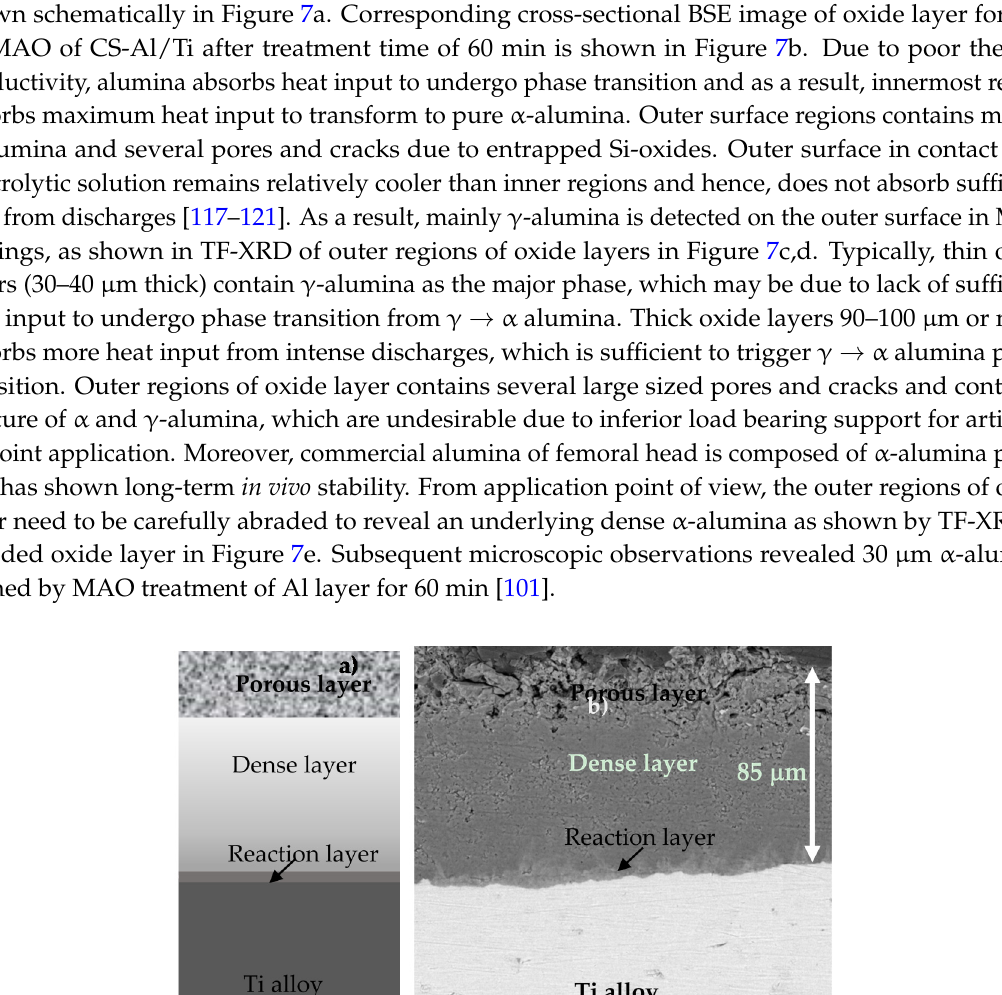
Figure 8. SEM image of cross ‐ section of alumina layer on the Ti alloy formed by MAO of CS ‐ Al layer at pulse frequency of 500 Hz ( a ) and 1000 Hz ( b ) both at duty cycle of 40% for 60 min. Reproduced from [102] with permission from Elsevier. Another possible way to improve the Vickers hardness of α‐ alumina is to increase the duty cycle process parameter of MAO treatment. Increasing the duty cycle results in longer working time in a single pulse that imparts large discharge energy within a pulse that might improve sinterability of alumina. It was revealed that increasing duty cycle from 40% to 60% increased Vickers hardness of α‐ alumina layer from 1658 to 1900 HV, which was reported to be due to decrease in mean micro ‐ crack size from 2 to 1 μ m, while the amount or thickness of the layer remained the same [102]. Pure and dense α‐ alumina formed under optimal MAO parameters of pulse frequency 500 Hz, duty cycle 60% and treatment time of 60 min is typically shown in SEM cross ‐ sectional image (Figure 9).